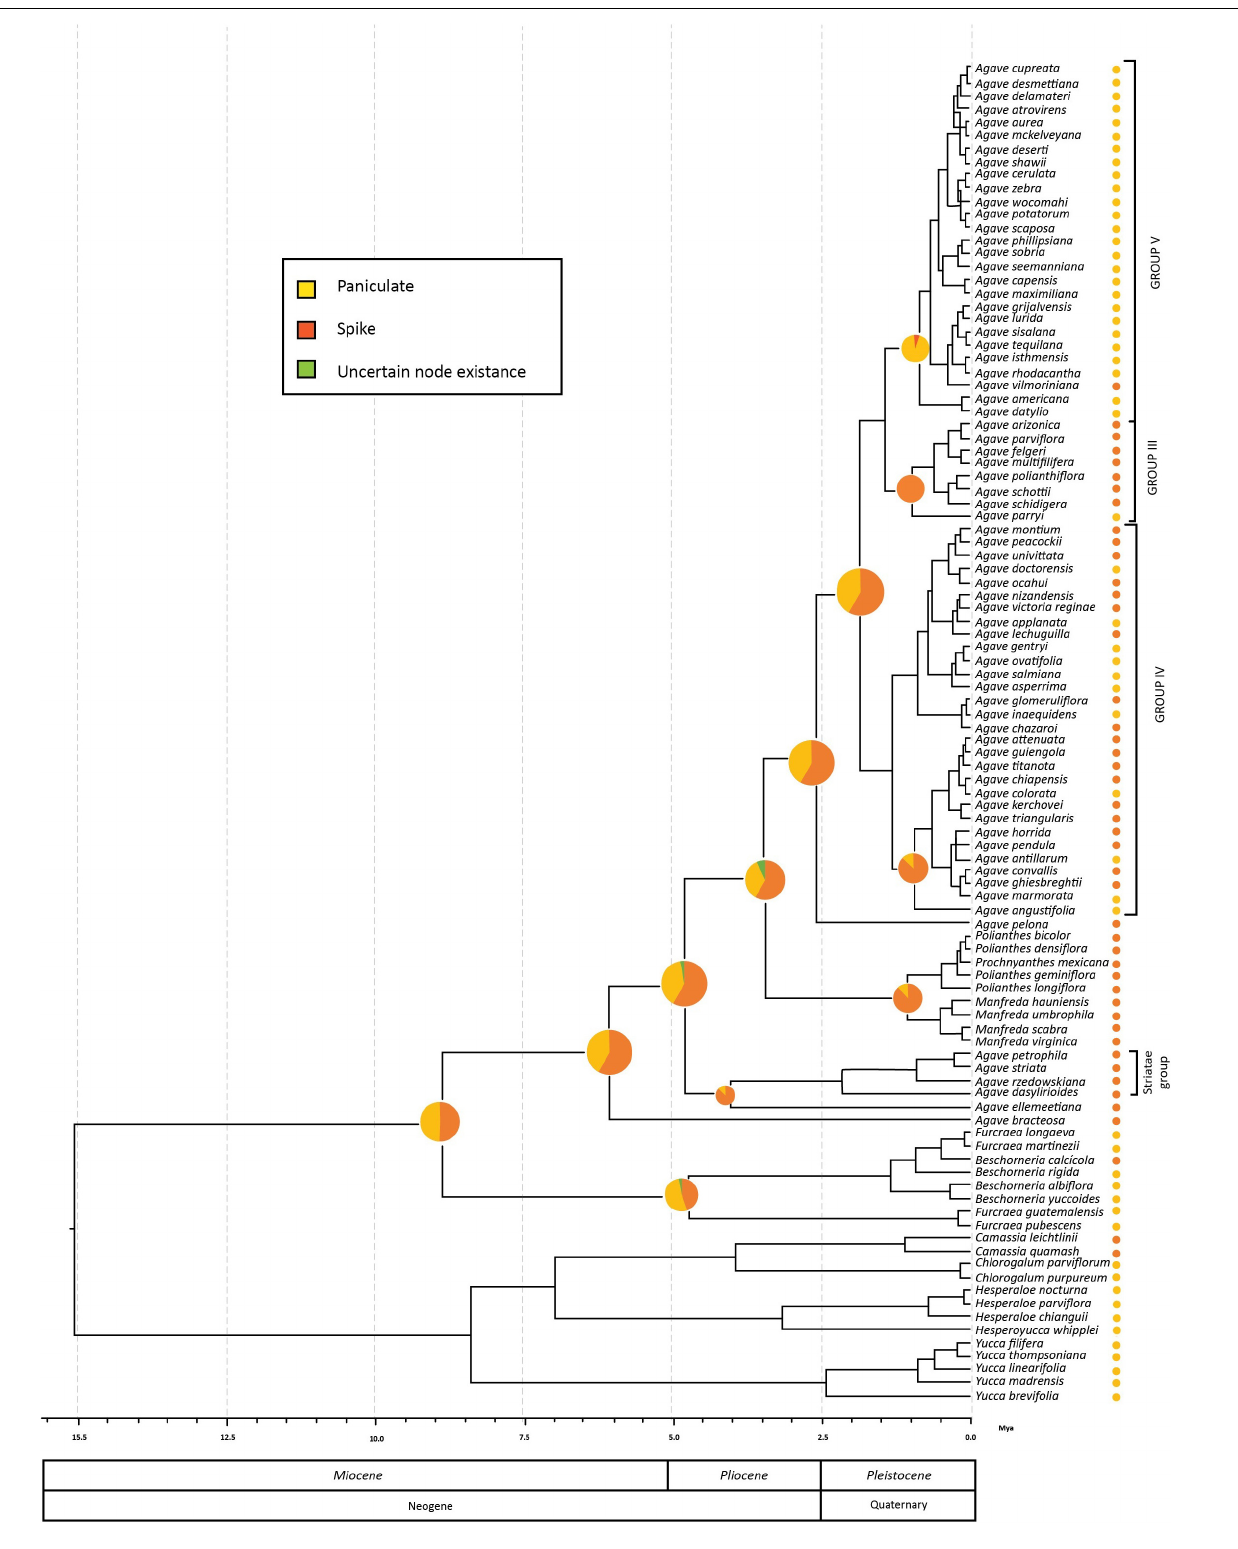
FIGURE 3 | Ancestral reconstruction of inflorescence type mapped onto Agave sensu lato chronogram resulting from BEAST analyses. Circles next to the tips taxa are coded to represent the actual inflorescence type. The pie charts show the probability values generated from BayesTraits for the ancestral inflorescence type reconstructed at each